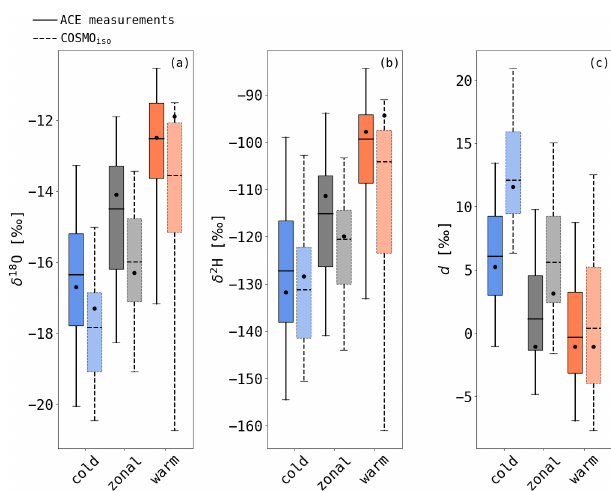
Figure 9. Box plots showing median (black horizontal line in box), interquartile range (boxes), mode (black dots) and [5, 95] percentile range (whiskers) of (a) δ 18 O, (b) δ 2 H and (c) d from ACE mea- surements (solid lines, dark colours) and COSMO iso simulations at the lowest model level (dashed lines, light colours) during cold tem- perature advection (blue), zonal flow (grey) and warm temperature advection